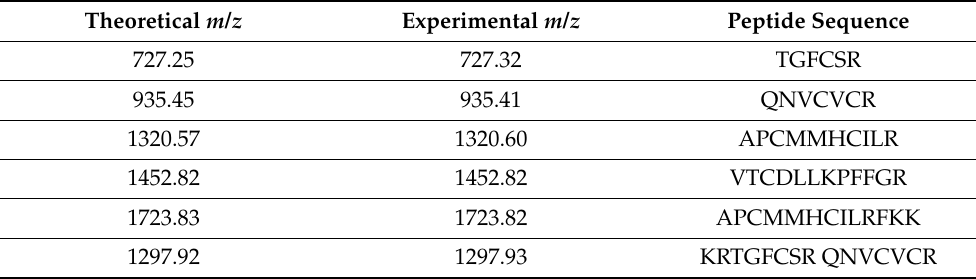
Table 1. Mass signals recorded in the MALDI-MS/MS spectra of the tryptic digest of car- boxyamidomethylated C-15867 peptide. The corresponding peptides are reported.